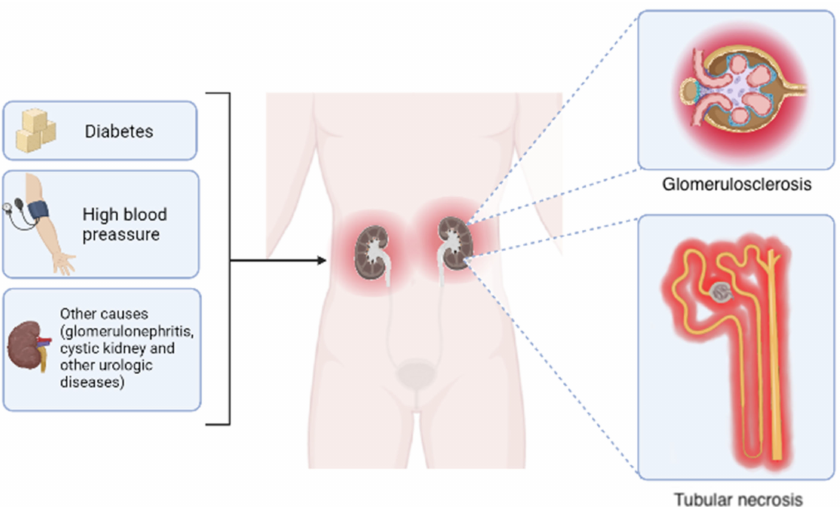
Figure 1. Primary causes and morphological outcomes of chronic kidney disease. Although the leading causes of chronic kidney disease include diabetes and hypertension, other disorders such as glomerulonephritis, cystic kidney disease, and diverse urologic diseases also contribute in a minor proportion. Regardless of the etiology, the progressive reduction in glomerular filtration rate occurs accompanied by two common histological changes: glomerular sclerosis and tubular necrosis. Elaborated in BioRender.com (accessed on 15 October